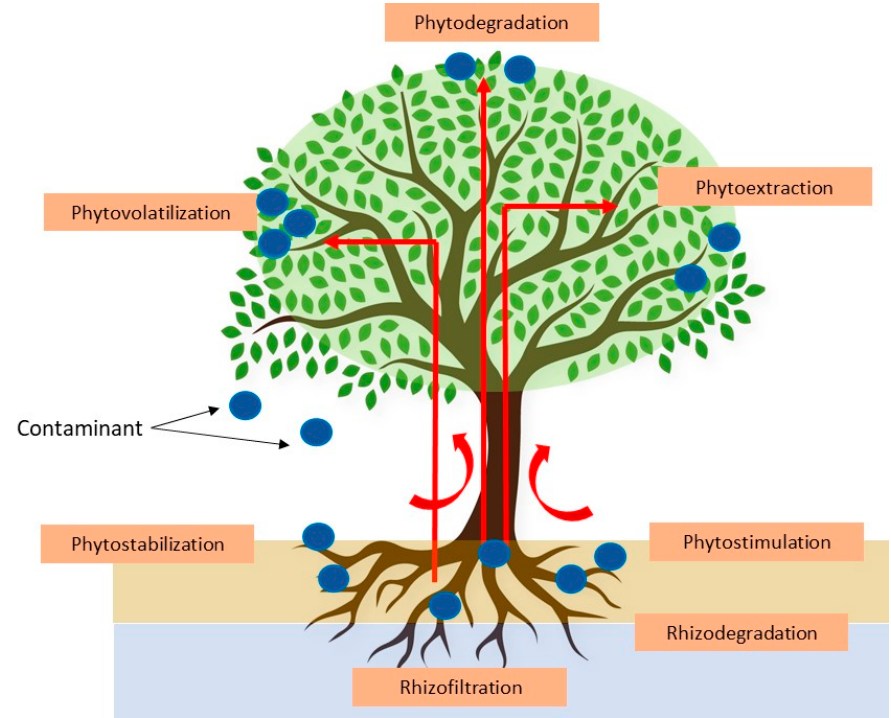
Figure 7. Descriptive illustration of phytoremediation techniques (adapted from [64]).